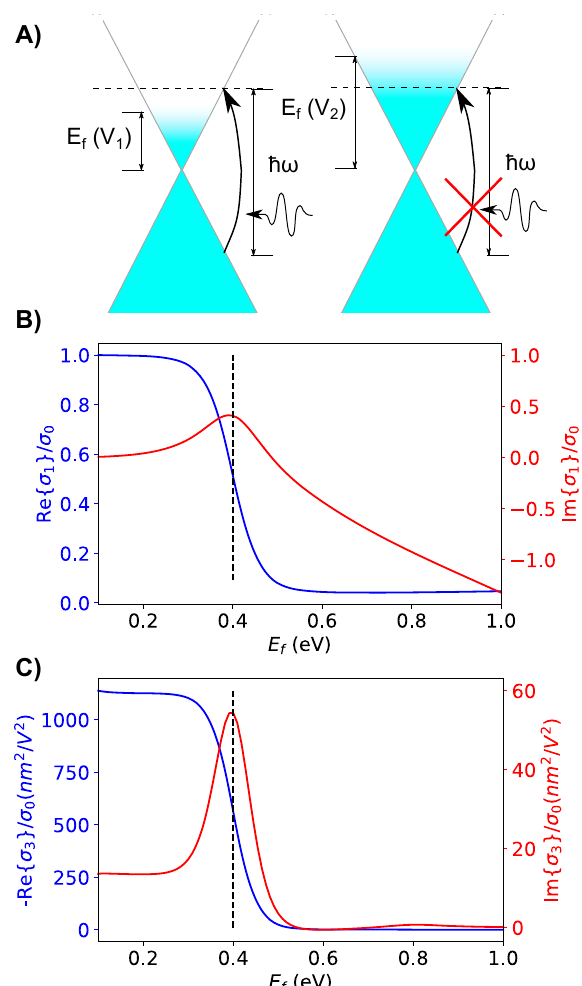
Figure 2: The effect of Fermi level on the conductivity of graphene. (A) Pauli blocking in graphene. The Fermi level allows or prevents photon absorption in graphene and is tuned by applying voltage | < | V | . (B) Linear surface conductivity of graphene as a function | V 1 2 of Fermi level. (C) Third order surface conductivity of graphene as a function of Fermi level. Both (B) and (C) assume 𝜆 Γ = 10 meV, T = 300 K and are normalized by 𝜎